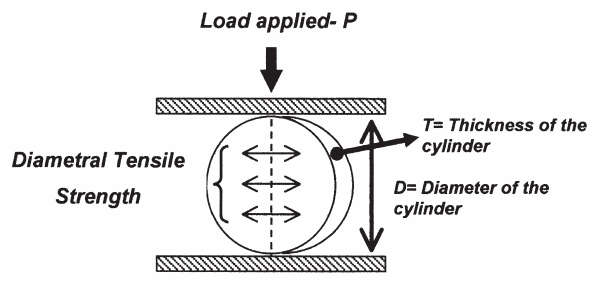
FIGURE 1- Schematic illustration of Diametral Tensile Strength adapted from Darvell 7 , 2000. How diametral tensile is envisaged ideally tension acting smoothly over the entire diameter, peak at the center 7 .